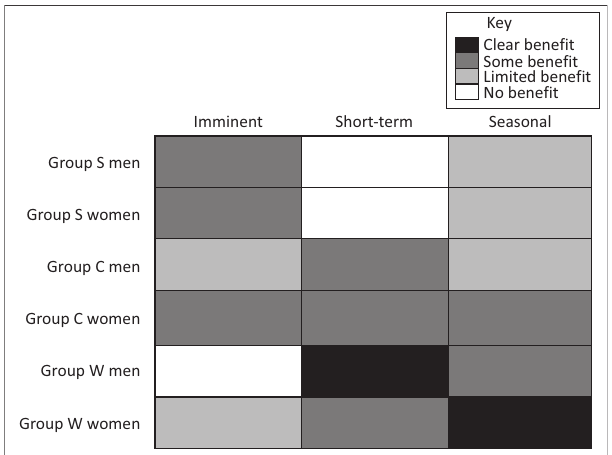
FIGURE 23: Graphical representation of who benefits from different timescales of early warning and the degree to which they